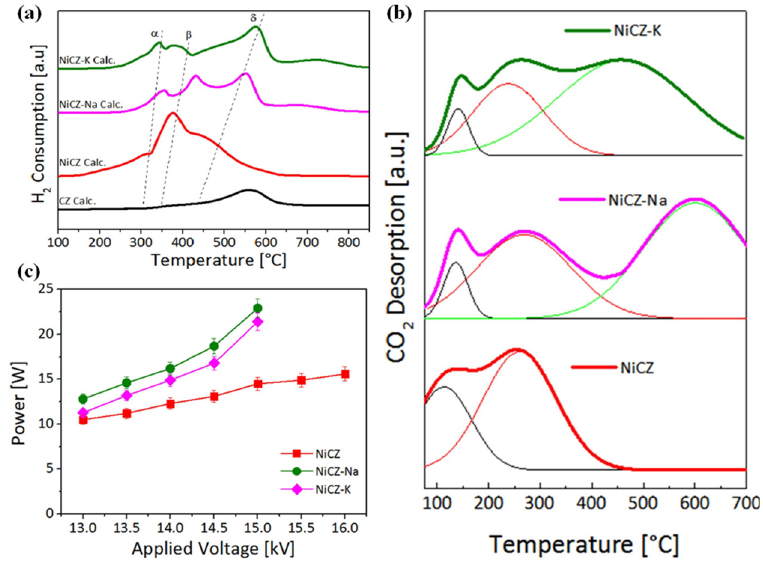
Figure 6. Characterization of the catalysts: ( a ) H 2 -TPR, ( b ) CO 2 -TPD, and ( c ) average power dissi- pated against the voltage for calcined catalysts. Reprinted with permission from [65]. Copyright 2021 Elsevier.